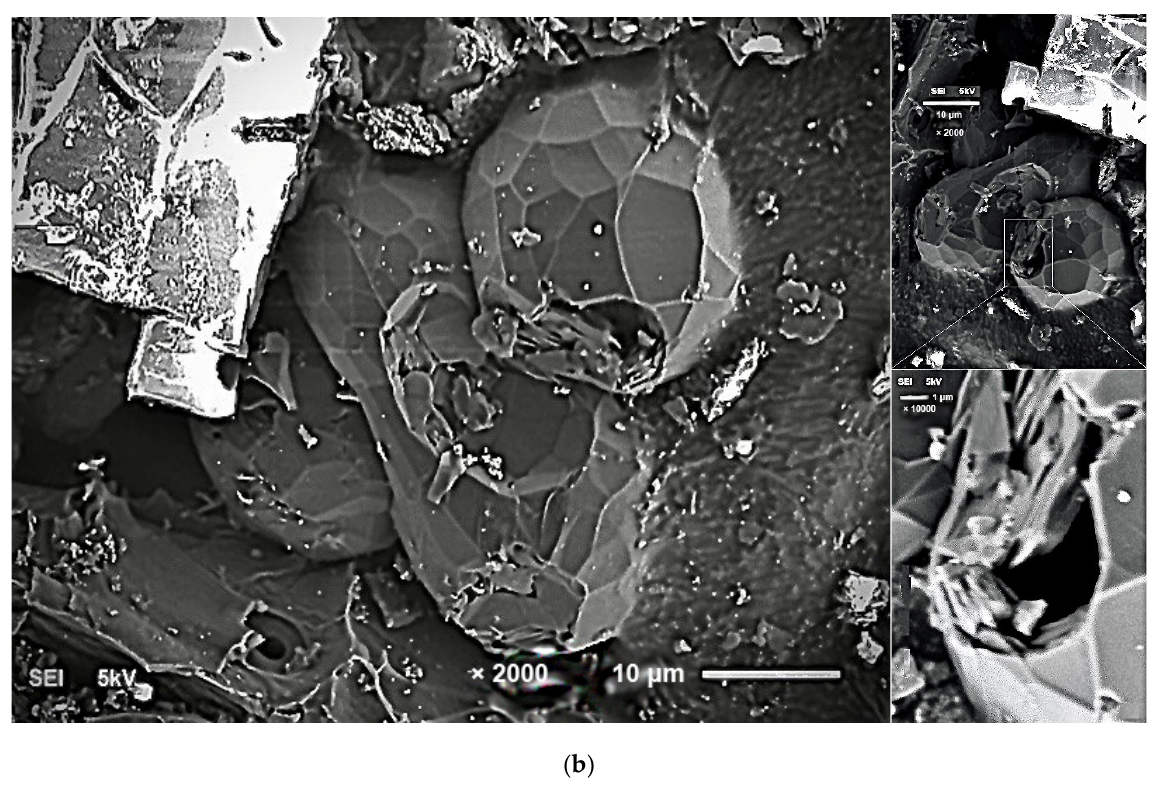
Figure 2. ( a ) Optical images of carbon particles in the dust of Chelyabinsk superbolide. Complex multifaceted polygonal nature of the particles is clearly seen in all images. In the bottom-right image the effective dimensions of 50 µ m multifaceted exotic microcrystal are indicated by arrows. ( b ) Scanning electron microscopy images of a conglomerate of complex polygonal exotic carbon microcrystals (ECM), including elongated particle (top, 2000 magnification) and zoomed bottom (10,000 magnification) rectangular area in top image. In the bottom image the multilayer graphitic nature of the particle and an extensive hollow inside the particle are clearly